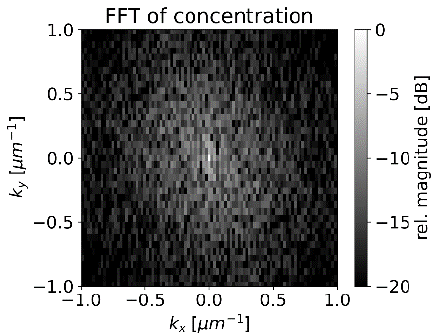
Figure 13. Small section of the discrete Fourier transformation of Carbon data (Figure 6) with the dominant frequencies.